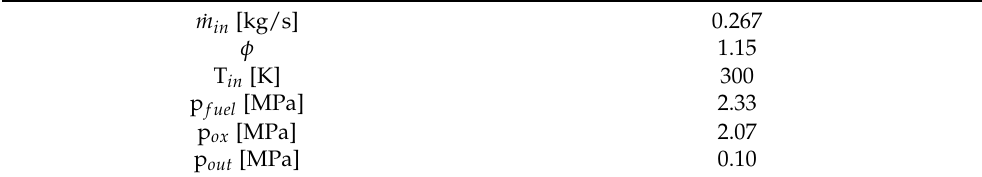
Figure 6. ( a ) Geometry cross-section of the RDRE used in the numerical model, ( b ) isometric view, and ( c ) top view of conceptual injector model [8,33]. Table 1. RDRE run